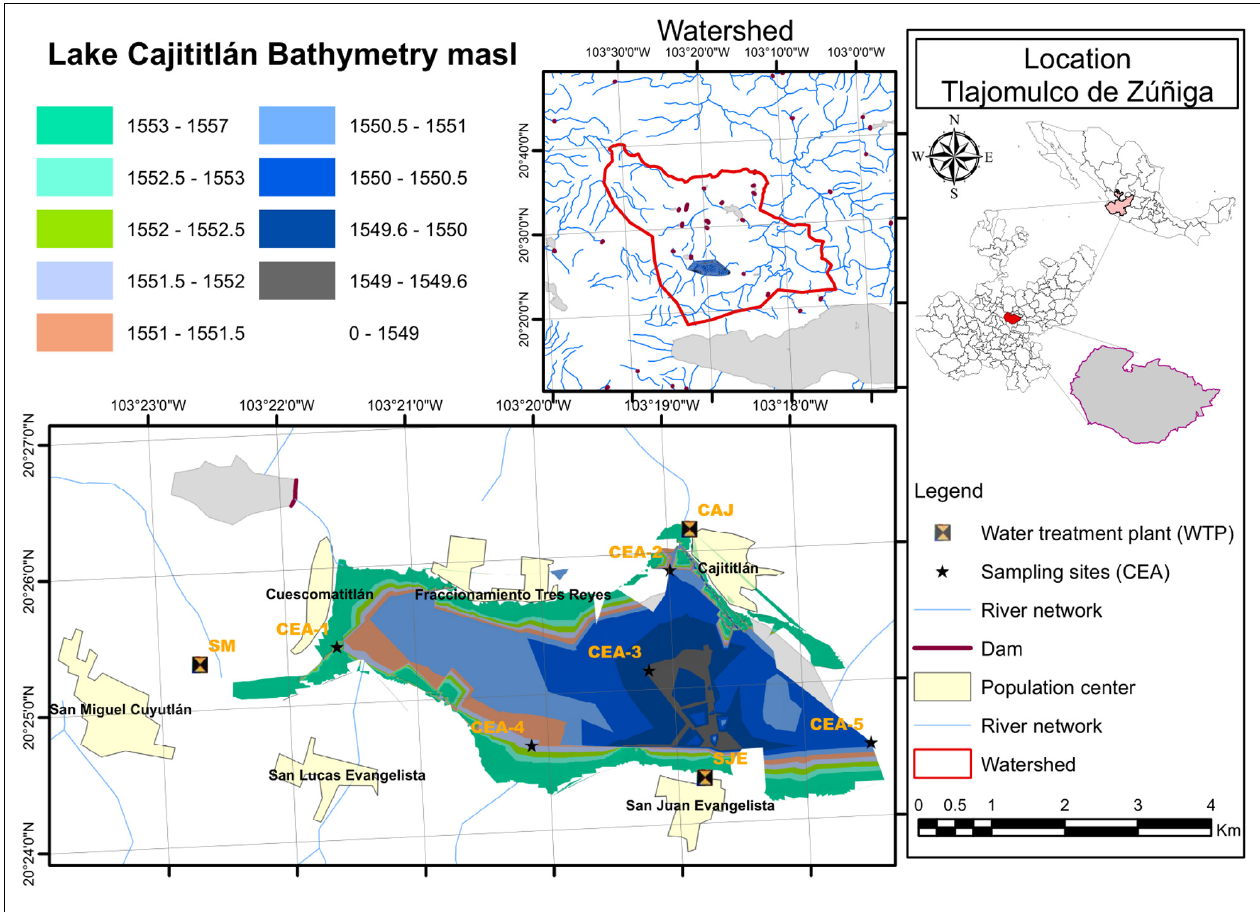
FIGURE 1 | Location of the sampling stations in Lake